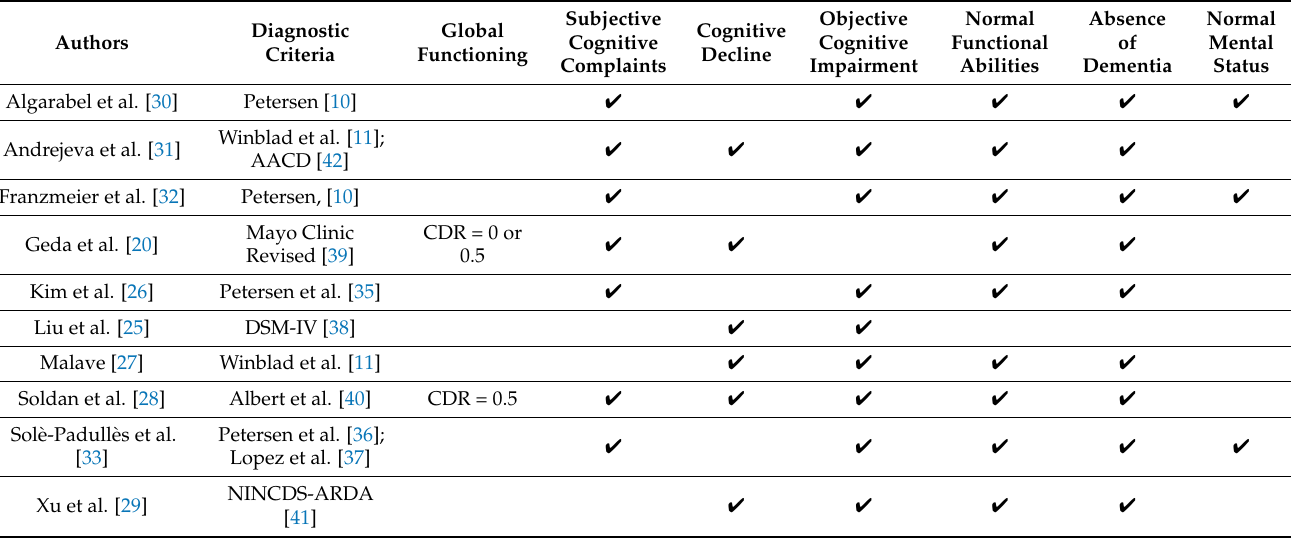
Table 3. Diagnostic Criteria.